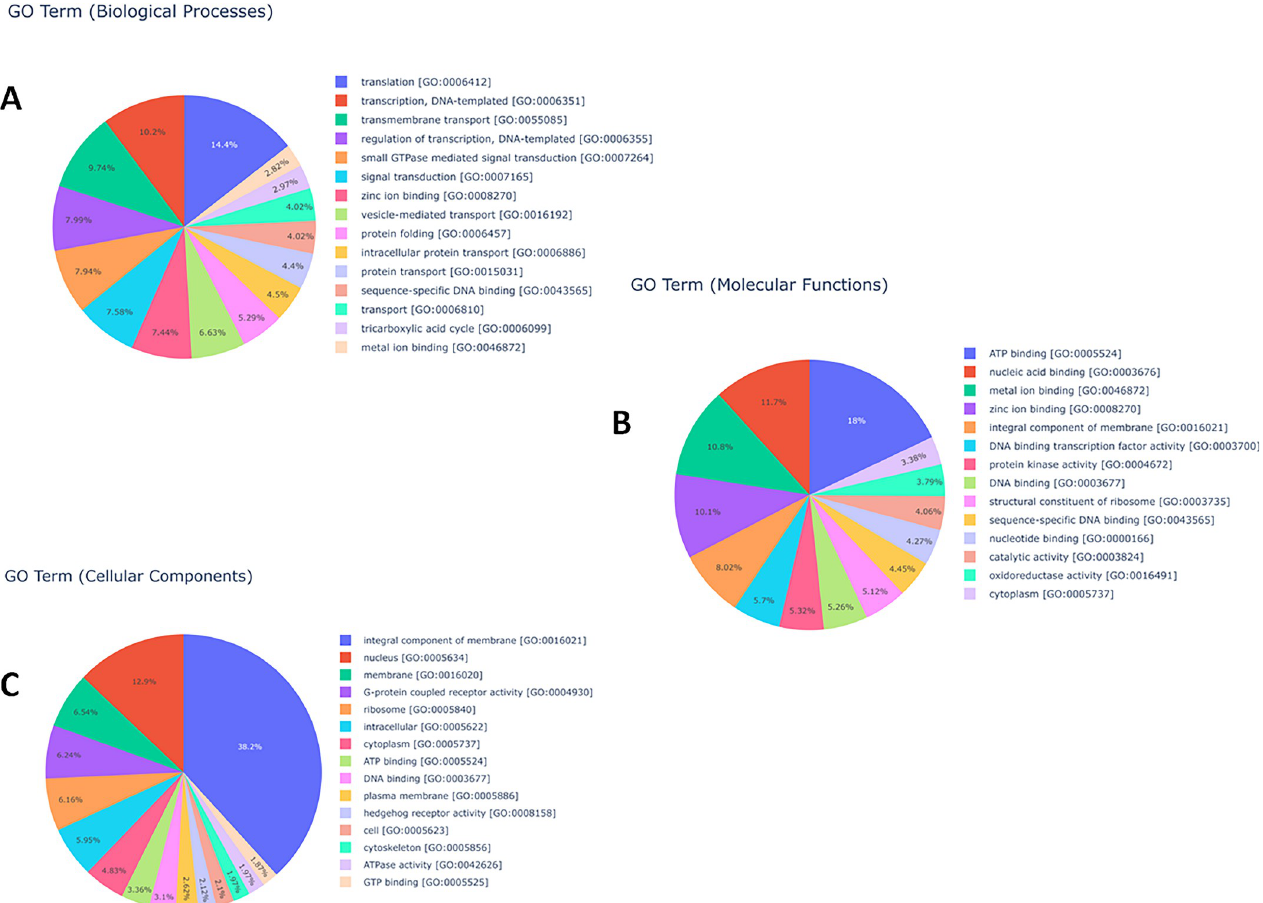
Fig 4. Top 15 gene ontology terms with respect to (A) biological processes (B) molecular functions (C) cellular components in the transcriptome of H . indica .